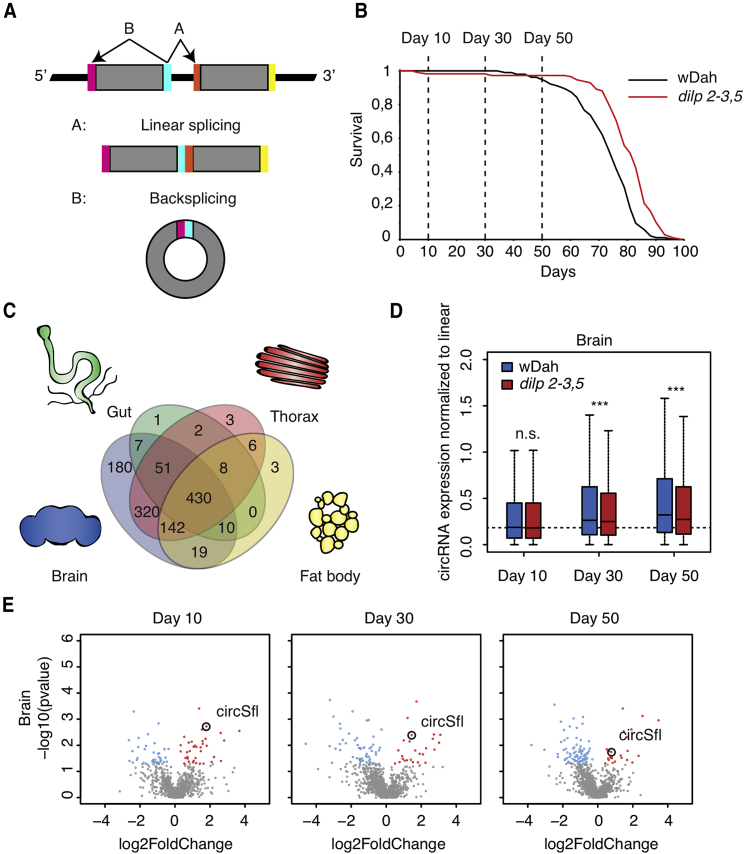
Tissue-Specific circRNA Profiling in Long-Lived Insulin Mutant Flies during Aging(A) Schematic overview of circRNA biogenesis by backsplicing.(B) For circRNA profiling, tissues of wild-type wDah flies and long-lived dilp 2-3,5 mutants were collected from young (day 10), middle-aged (day 30), and old (day 50) female flies.(C) circRNAs were highly enriched in the brain of wDah control flies compared with the thorax, gut, and fat body.(D) Global accumulation of circRNAs in the brain with age was reduced in long-lived dilp 2-3,5 mutant flies (age, p < 0.0001; genotype, p < 0.001; interaction, p < 0.05; 2-way ANOVA, n = 3, median with 25th/75th percentile [box] and minimum/maximum [error bars]).(E) Volcano plots of differentially expressed circRNAs in brains of dilp 2-3,5 mutant flies at days 10, 30, and 50. Significantly upregulated circRNAs are highlighted in red and significantly downregulated circRNAs in blue (p < 0.05, beta-binomial test, n = 3). CircRNA expression was normalized to its host gene. circSfl was consistently upregulated in dilp 2-3,5 mutant flies.See also Figure S1 and Data S1 and S2.